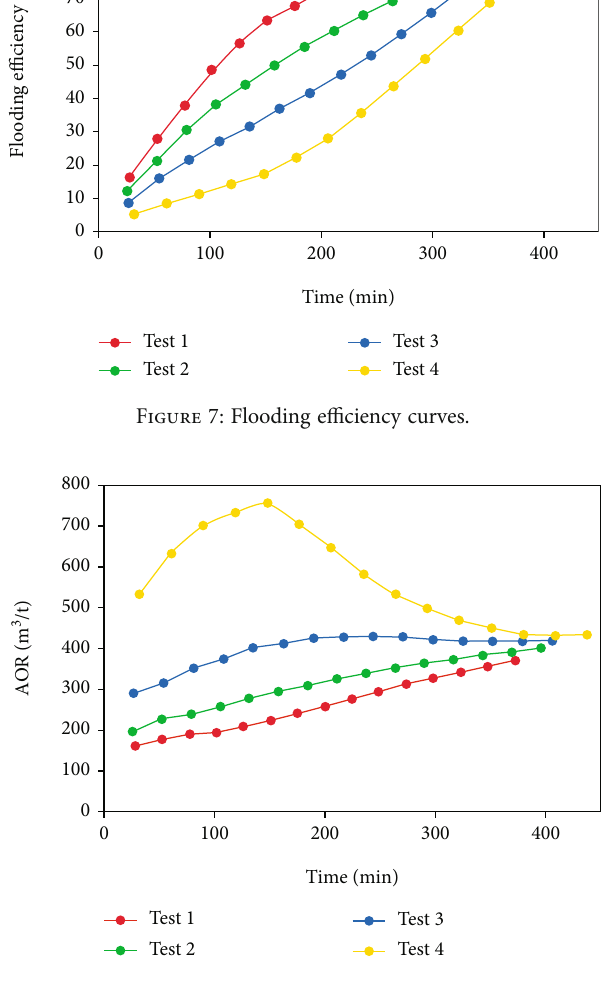
Figure 6: Water cut curves.